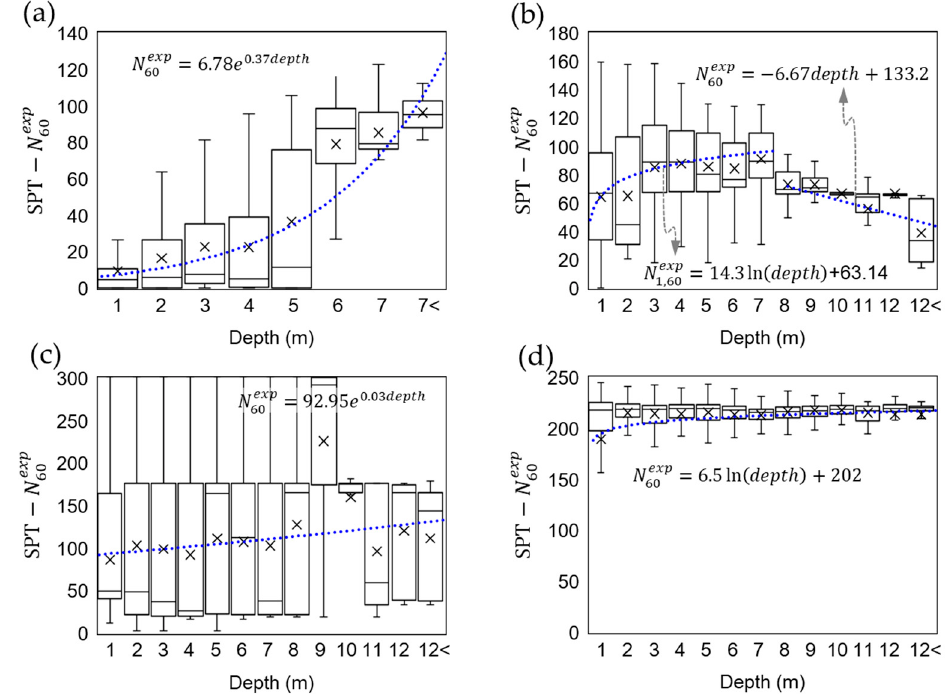
Figure 9. Box plots of correlations between grid-based predicted geo-layer depth and average N exp : ( a ) fill layer; ( b ) alluvial soil; ( c ) weathered soil; ( d ) weathered rock. The blue dotted lines show the regression line and equations with the highest R 2 .